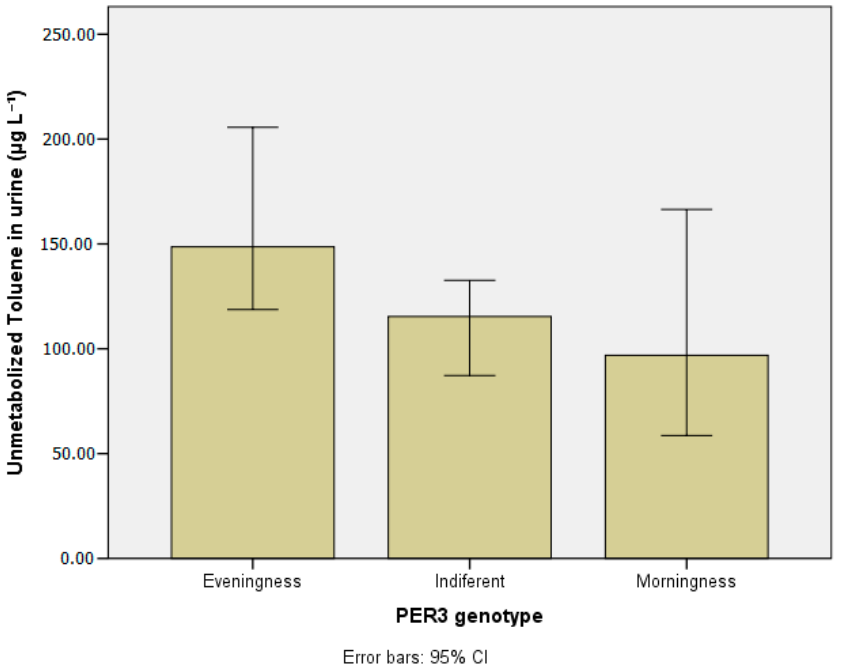
Figure 9. Unmetabolized toluene in urine ( μ g L − 1 ) according to PER3 gene VNTR polymorphisms.